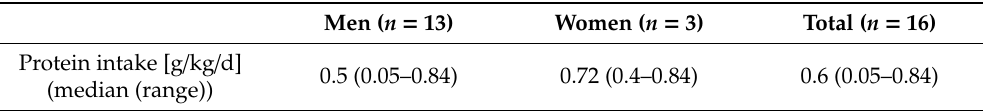
Table 5. Protein intake calculated from a FFQ in 16 patients treated with